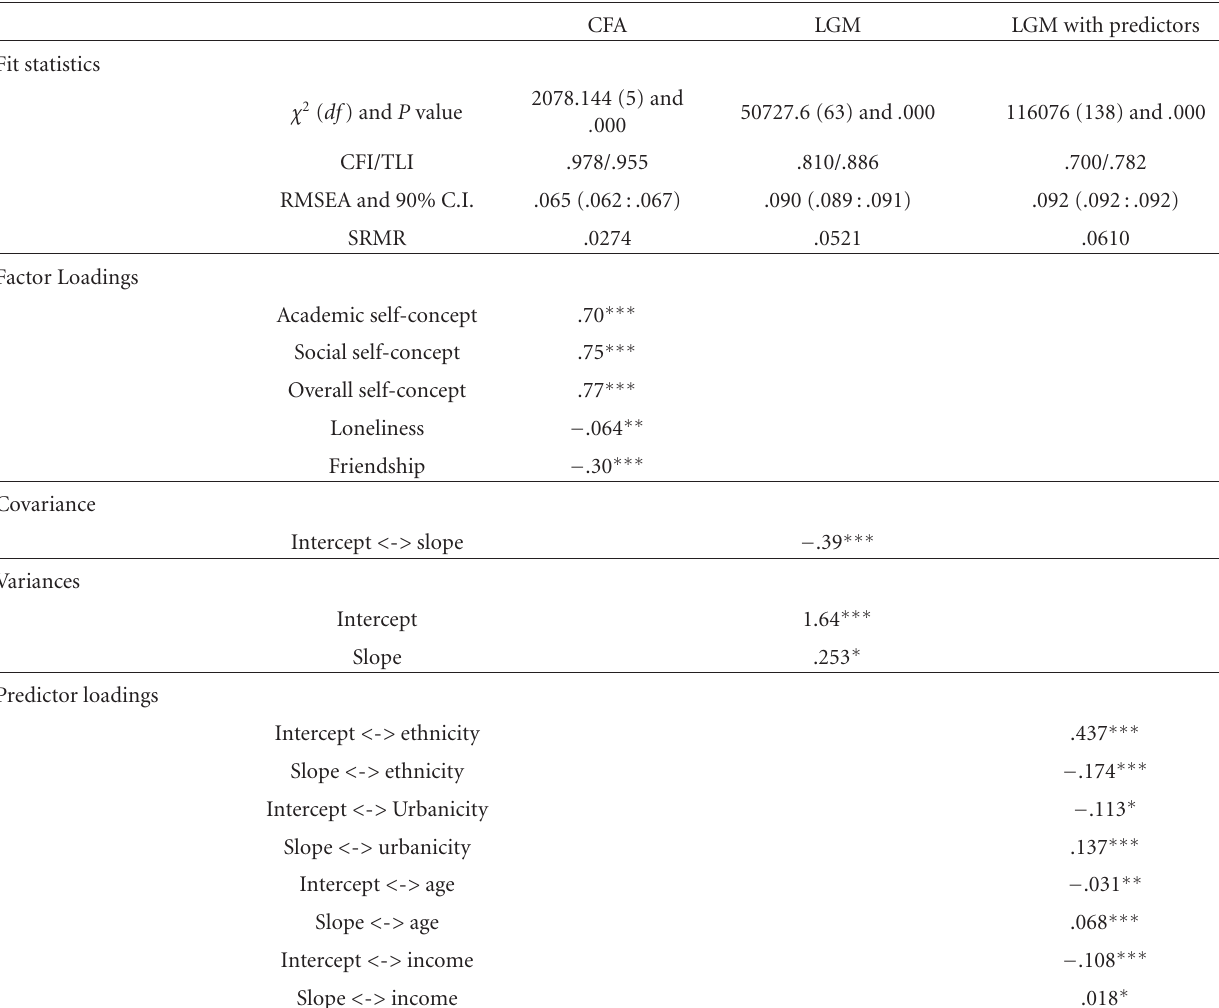
Table 3: Confirmatory factor analysis and latent growth